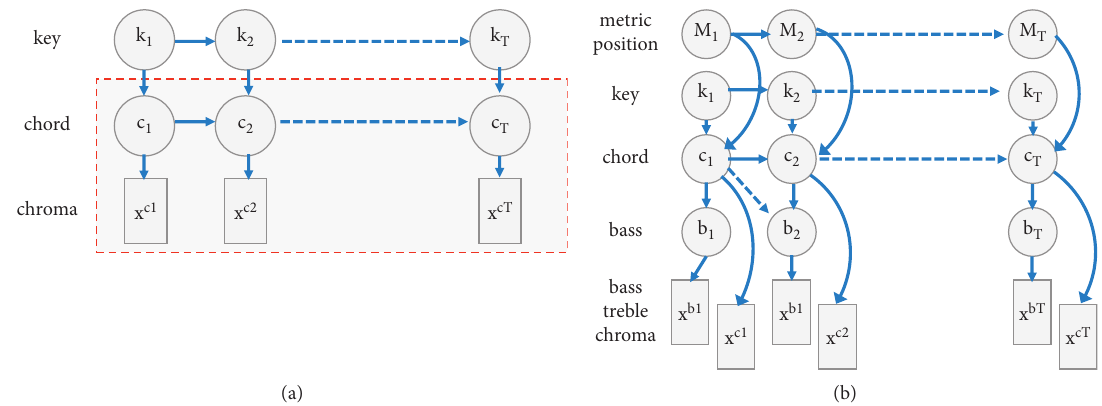
Figure 4: The development of HMM topologies for key/chord estimation systems (a). (b) Image adapted from